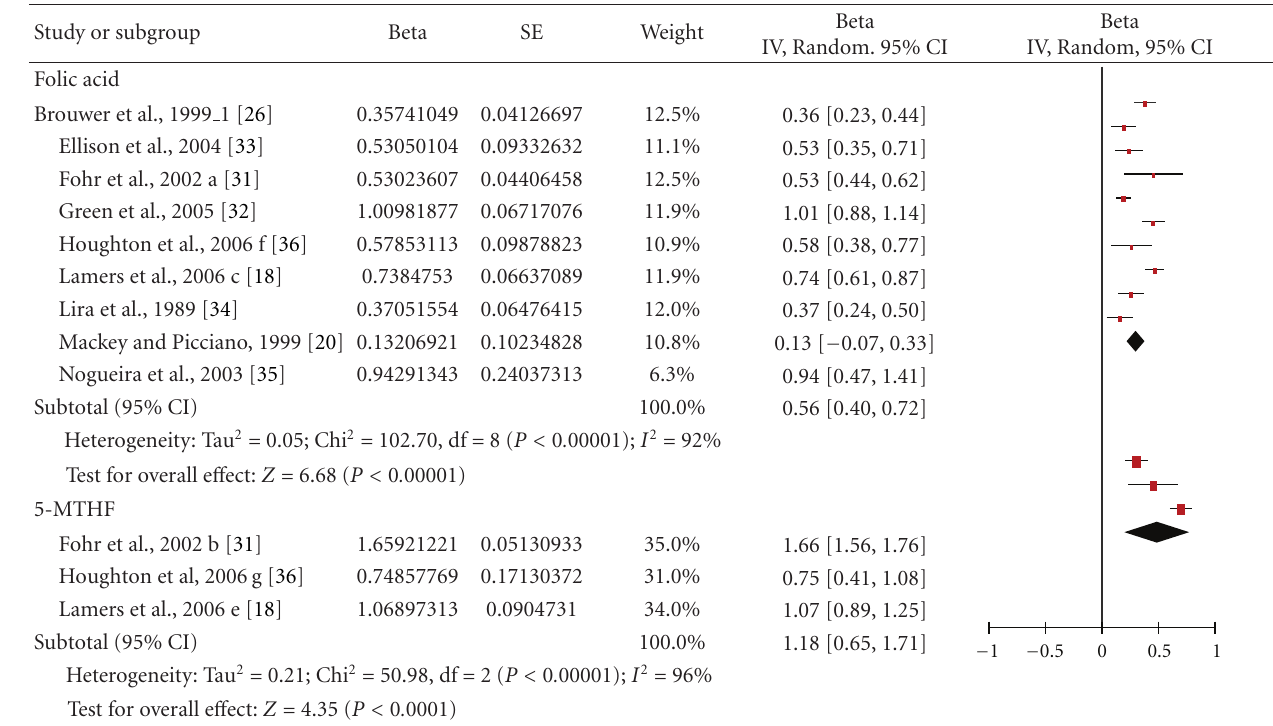
Table 5: Forest plot of the e ff ects of total folate supply (i.e., supplement plus dietary folate), with the supplement in form of folic acid